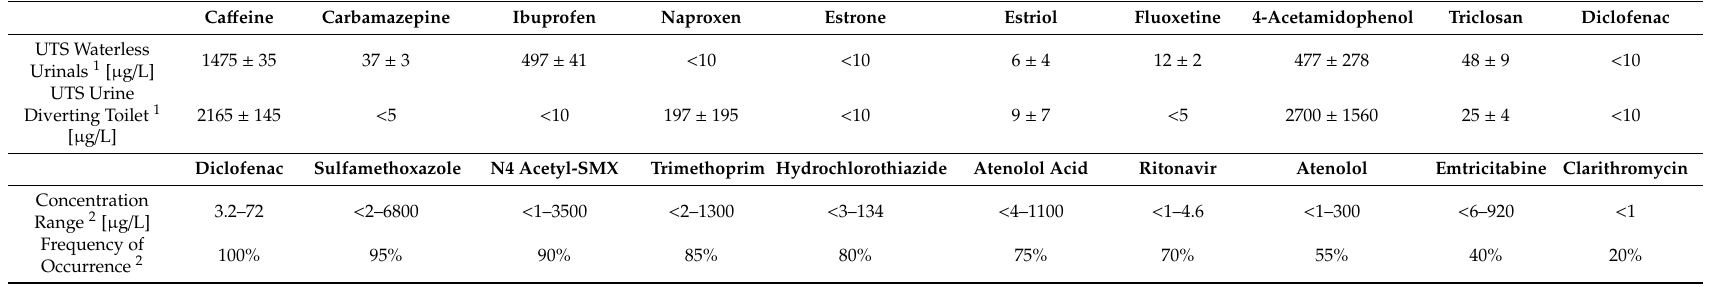
Table 2. Pharmaceutical and hormone concentrations in human urine from the literature. The results from the first two rows are from the analysis conducted at the University of Technology Sydney (UTS) urine source separation system. The main di ff erence between waterless urinals and urine-diverting toilets is that, in the latter, urine gets diluted two to four times with tap